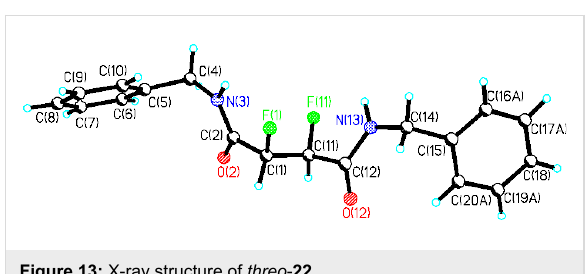
Figure 13: X-ray structure of threo - 22 .